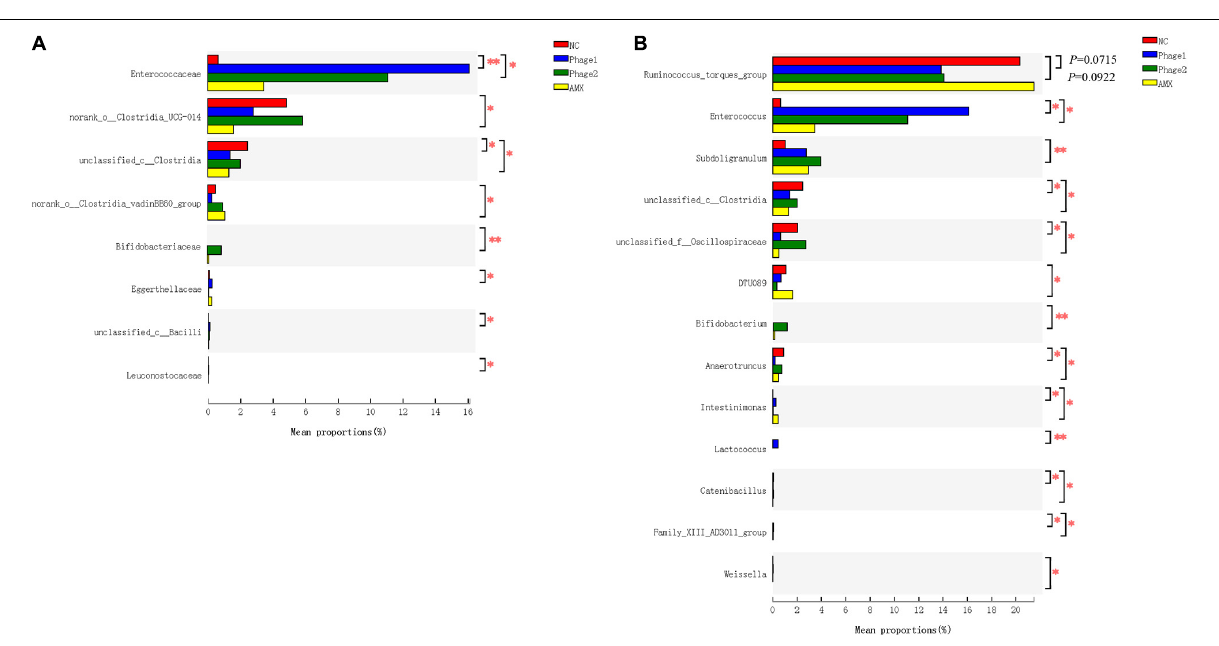
Frontiers in Microbiology |